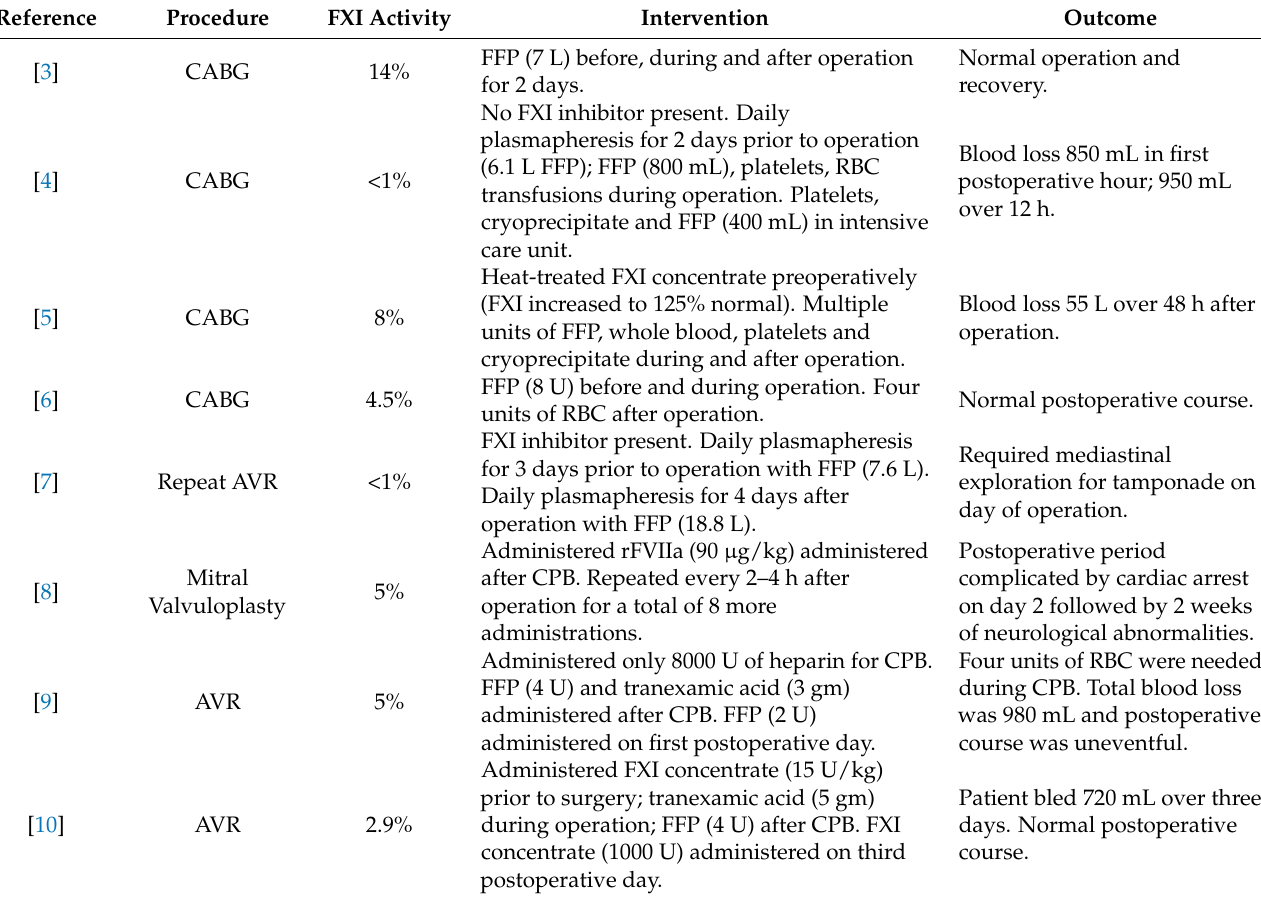
Table 2. Management of severe FXI deficiency for CPB and